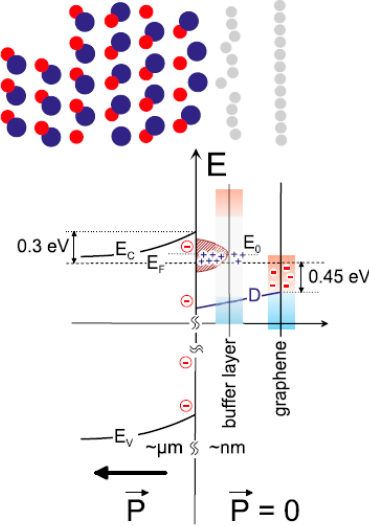
Figure 8. Sketch and band diagram for monolayer EG on SiC(0001). Blue and red circles indicate Si and C atoms, respectively. The polarization is shown at the bottom. The negative polarization related to the discontinuity of the interface polarization is a pseudo charge (marked in circles). D indicates the electrostatic potential between the EG and SiC. The band bending details have been taken from Reference [83]. Adapted with permission from Reference [81]. Copyright (2012) American Physical Society.